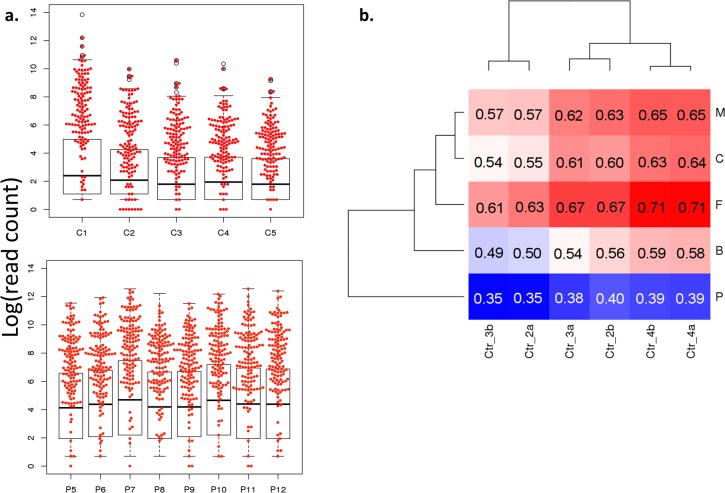
Comparison of the 142 miRNA that were commonly observed across control duplicates against published mother plasma (M), father plasma (F), fetal plasma (B), placenta (P), control female plasma (C) miRNA results.a) These miRNA were found to be significantly enriched among the highly expressed miRNA across all sample types (M, F, B types not shown). b) The correlation of these miRNA expression were high among the plasma samples (M, F, B, C), but low compare to placenta (P).